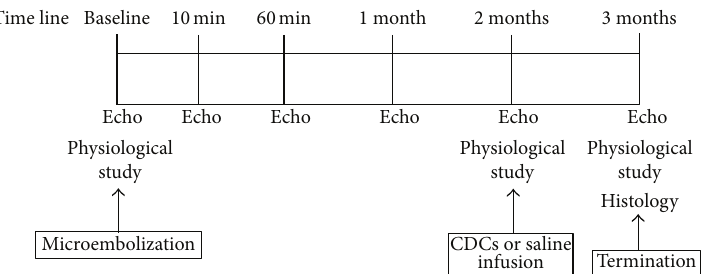
Figure 1: Study protocol for microembolization and CDC